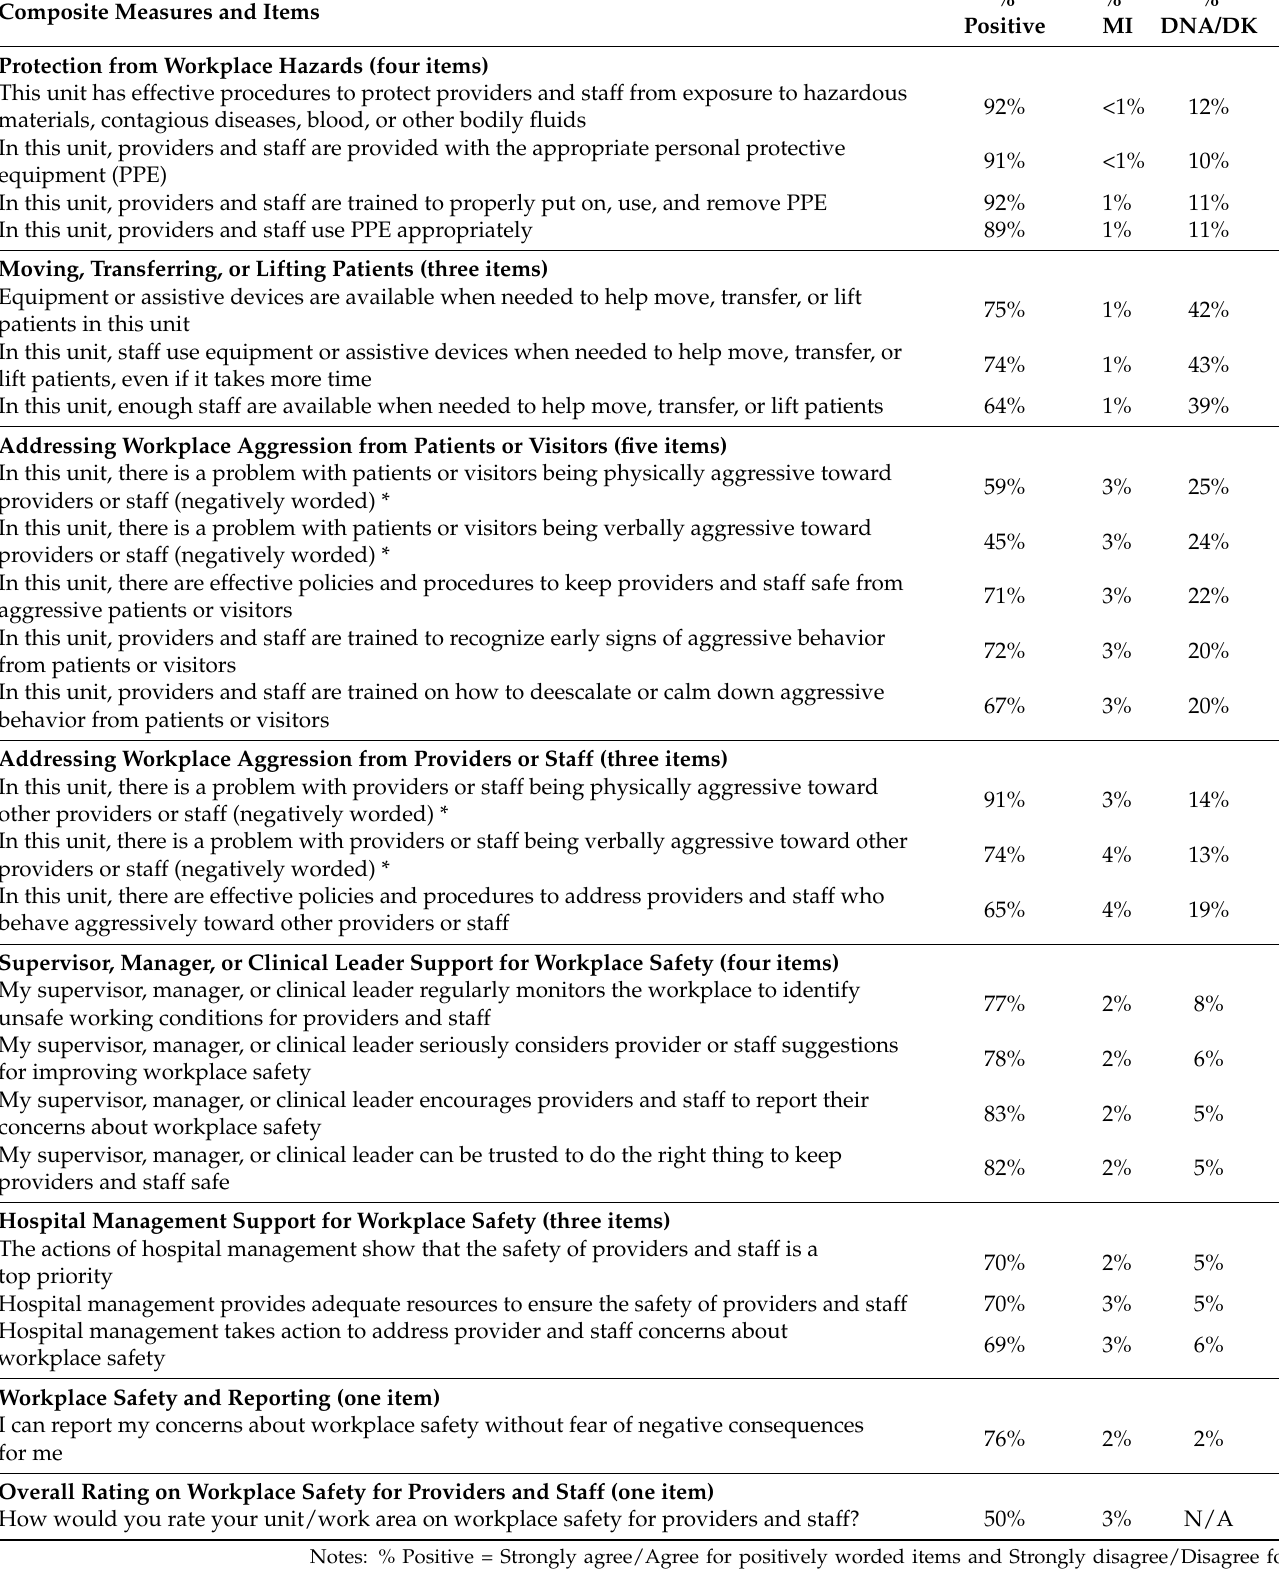
Table 5. Item analysis results ( N =